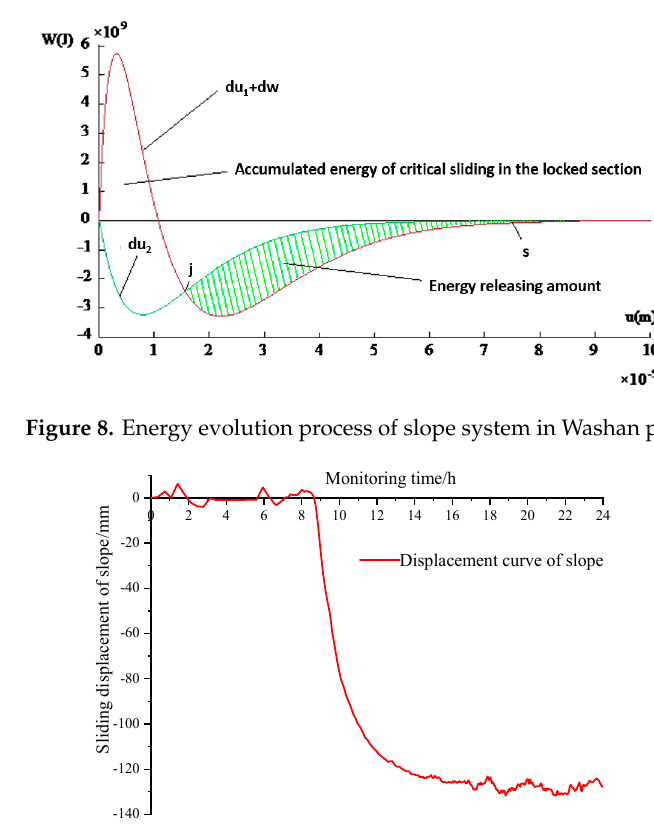
Figure 9. Displacement curve of slope instability process. Energies 2020 , 13 , 1128